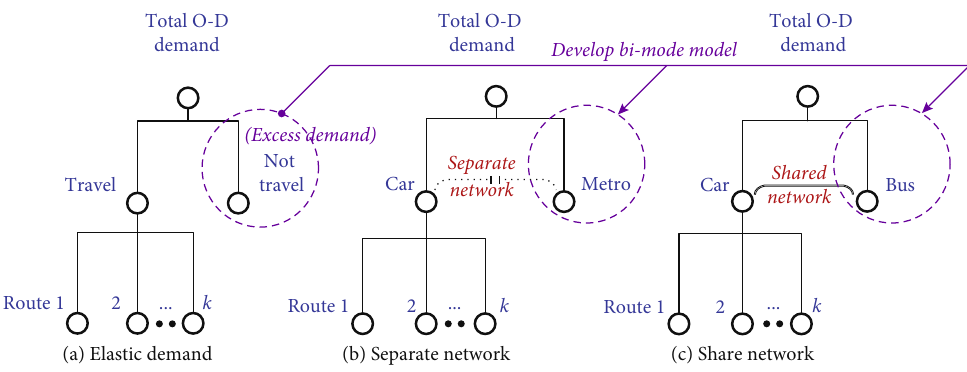
Figure 2: Similar structures for elastic demand model and bimodal